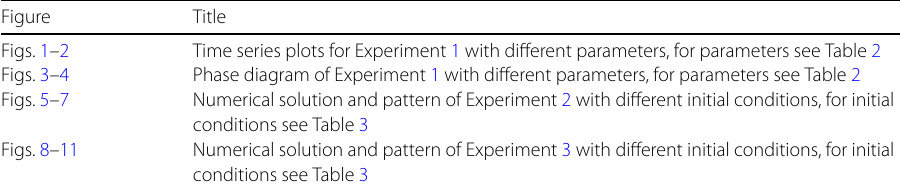
Table 2 Parameters of Figs. 1–11 Figure Parameters